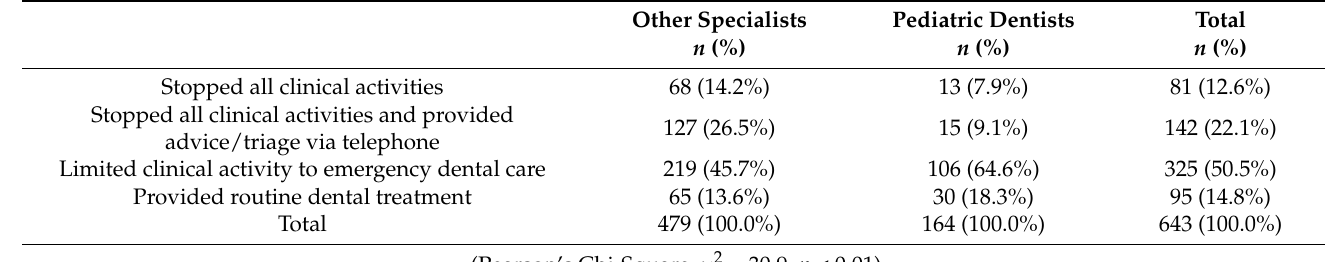
Table 3. Working regime during the state of emergency in pediatric dentistry compared to other